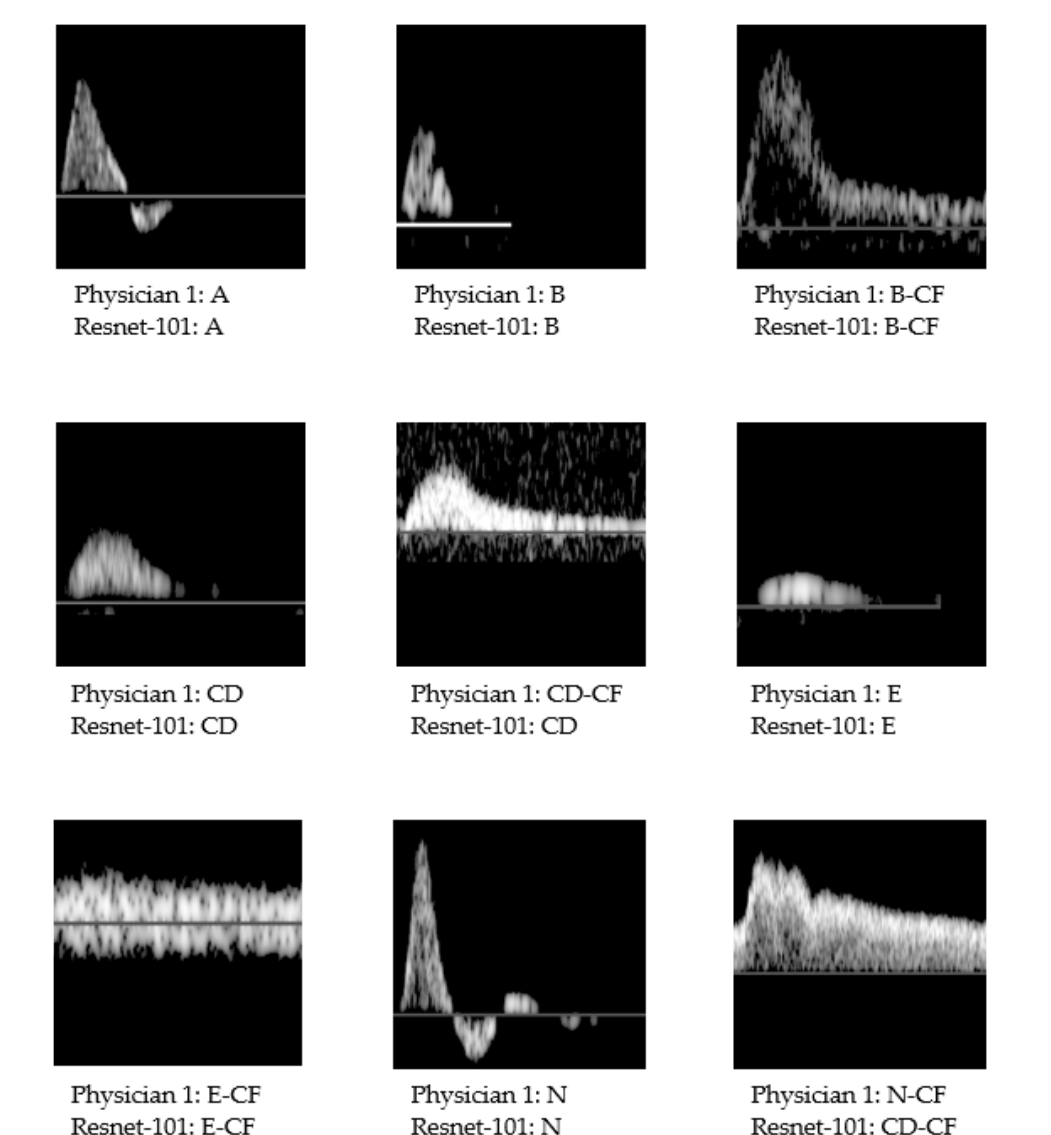
Figure 3. Example of waveforms categorized by ResNet-101 in comparison with the waveform categorization performed by physician 1, according to the simplified Saint-Bonnet classification. Physician 1: reference physician.